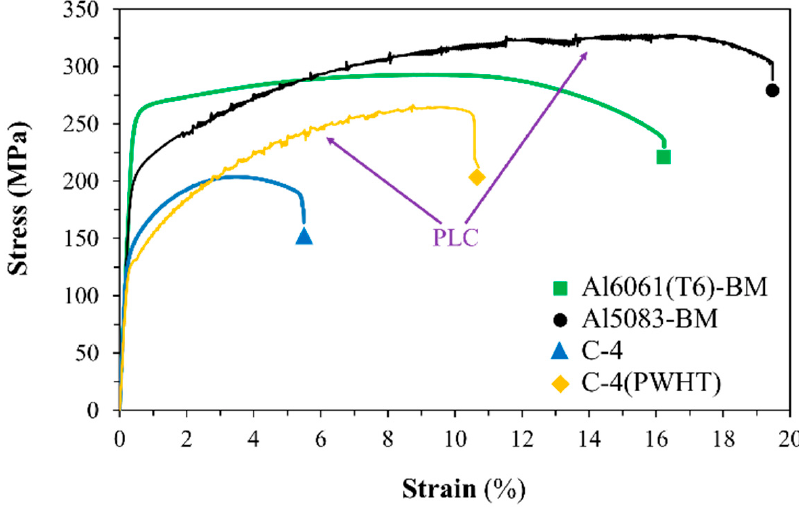
Figure 6. Tensile properties of FSWed and PWHTed of the Al5083-Al6061(T6) dissimilar